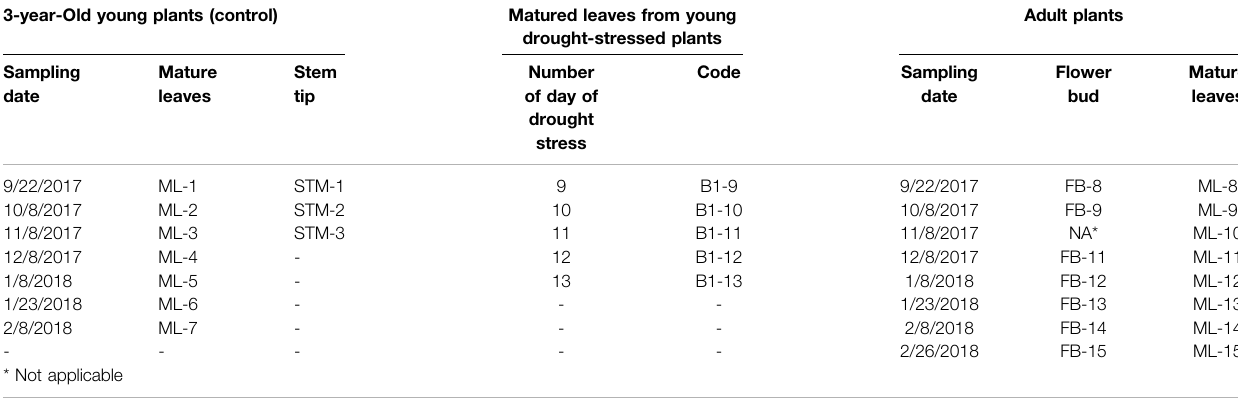
TABLE 1 | Sampling periods used for tissue collection during the study.